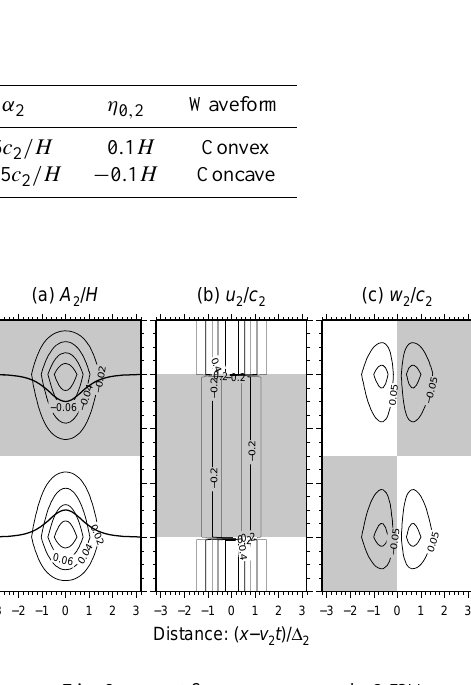
Fig. 6. The left (a) , middle (b) , and right (c) panels represent the contours of amplitude ( A 2 ) and horizontal ( u 2 ) and vertical ( w 2 ) current components for a convex mode-2 ISW as functions of distance and depth, respectively. The left panel also displays A 2 at the upper and lower interfaces. All components were nondimensionalized using a horizontal length scale 1 2 (nonlinear characteristic width of a mode-2 ISW), a vertical length scale H (depth), and a speed scale c 2 (linear phase speed of a mode-2 ISW). Shaded areas show negative values. The contour intervals are 0.02, 0.1, and 0.05 for A 2 , u 2 , and w 2 , respectively.